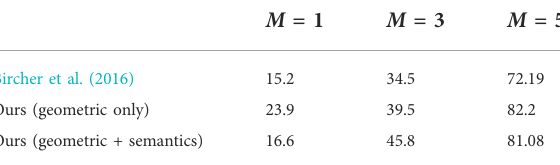
TABLE 4 Average information gain per iteration